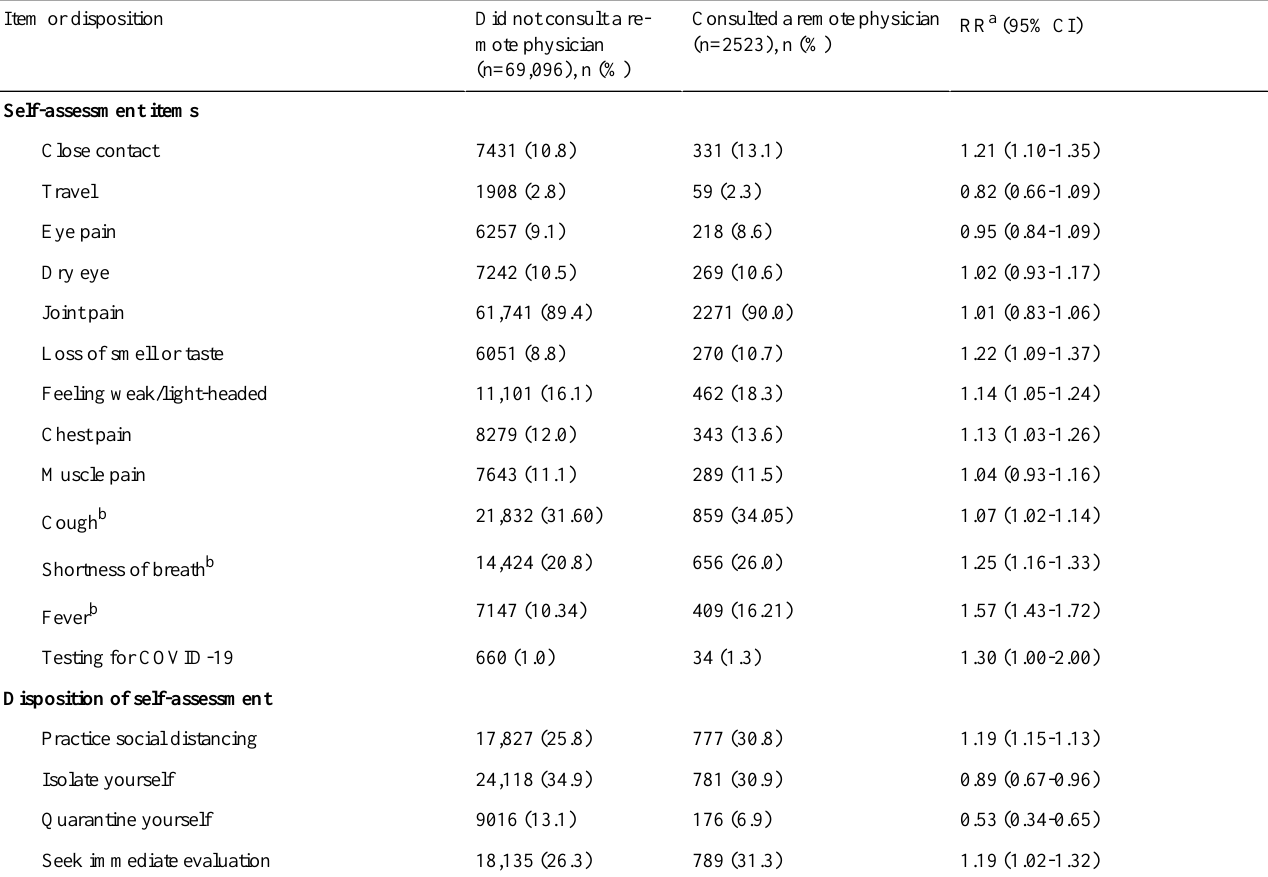
Table 3. User characteristics and self-assessment protocol disposition associated with consulting a remote physician